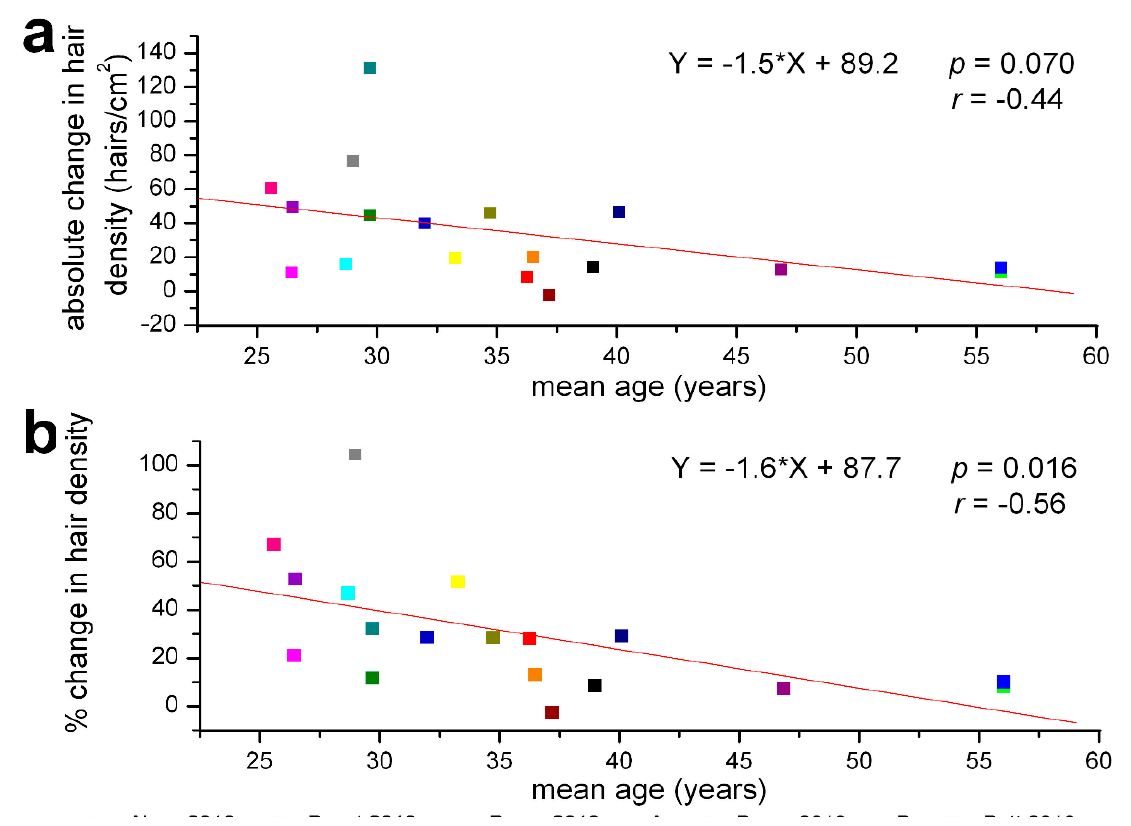
Figure 6. Correlations between the mean age of experimental groups and absolute or percentage change in hair density within the clinical trials selected for meta-analysis. ( a ) almost significant correlation with the absolute changes in hair density (hairs/cm 2 ) at the end of evaluation period. ( b ) significant correlation with percentage changes in hair density relative to initial values (same legend for both graphs). The regression lines are plotted in red, and the corresponding equations, the values of the correlation coefficients r, and their probabilities p are marked on each graph.